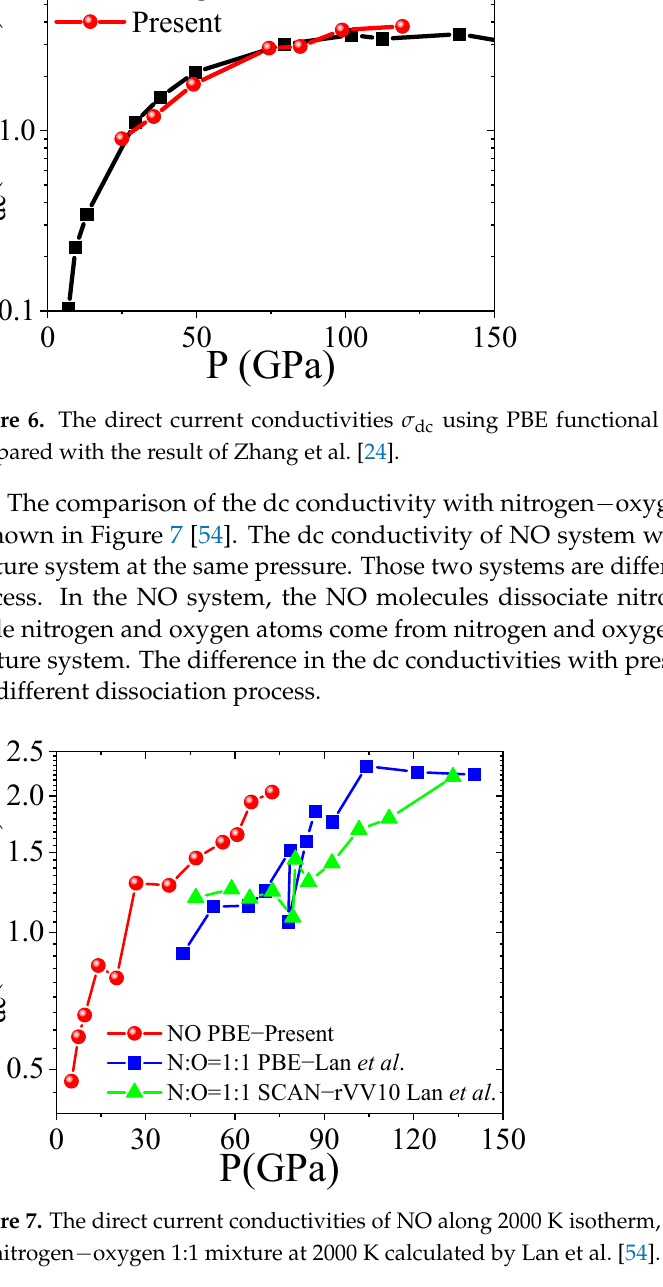
Figure 5. Fractions of components in warm dense NO along Hugoniot using PBE functional. The components contain NO molecules, N and O atoms, N 2 and O 2 molecules, and Other.